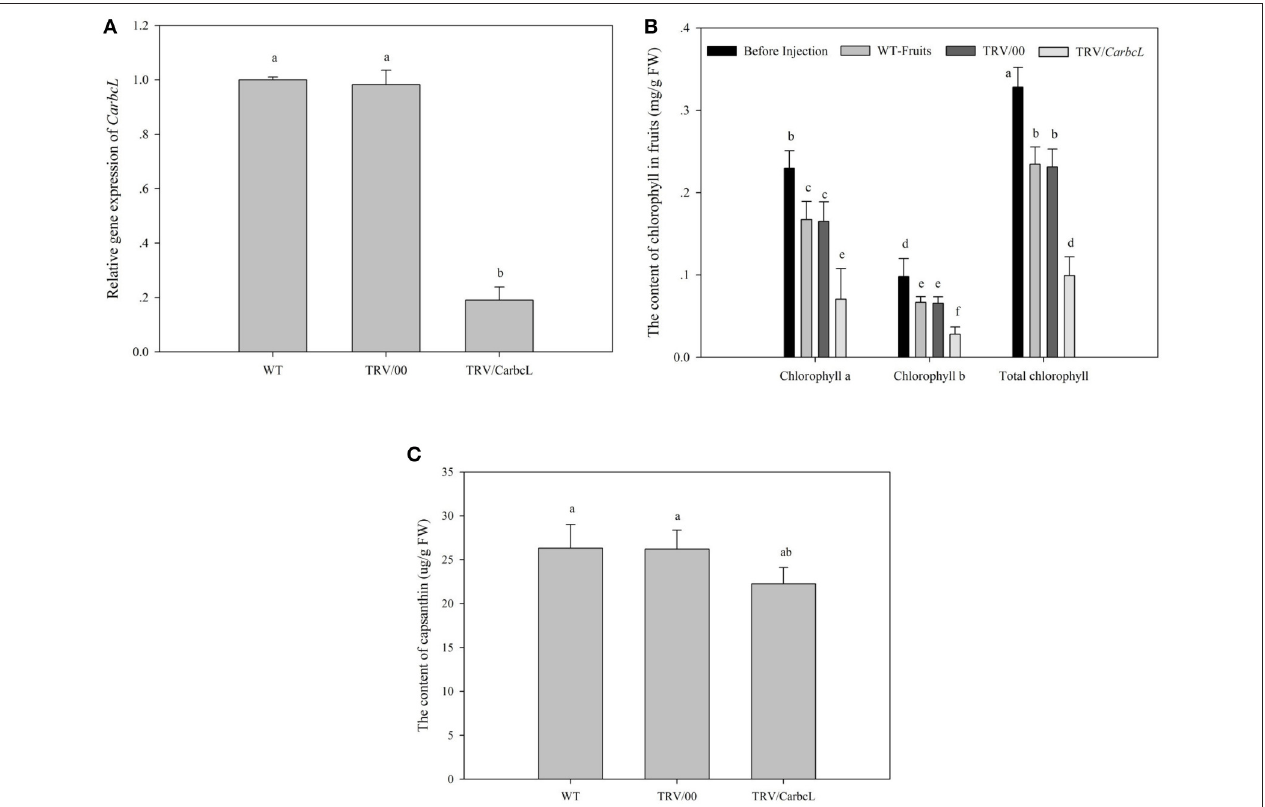
FIGURE 5 | Changes in gene expression level, chlorophyll content and fruit capsanthin content after gene silencing. WT, the control group; TRV/00, the empty vector group; TRV/ CarbcL , the treatment group. (A) The changes in gene expression level after silencing; Ubi3 (AY486137.1) was used as an internal control by using qRT-PCR; (B) the changes in fruit chlorophyll content after gene silencing; Before injection, the content of chlorophyll before the sample was treated; WT-Fruits, the content of chlorophyll in the control group; TRV/00, the content of chlorophyll in the empty vector group after 10 days of treatment; TRV/ CarbcL , the content of chlorophyll in the treatment group (fruits were injected TRV/ CarbcL ) after 10 days of treatment; (C) the changes in fruit capsanthin content after gene silencing; the content of capsanthin in the control group; TRV/00, the content of capsanthin in the empty vector group; TRV/ CarbcL , the content of capsanthin in the treatment group; LSR analysis at 5% is shown in lowercase letters (a and b). Means with the same letter are not significantly different. All experiments were carried out in